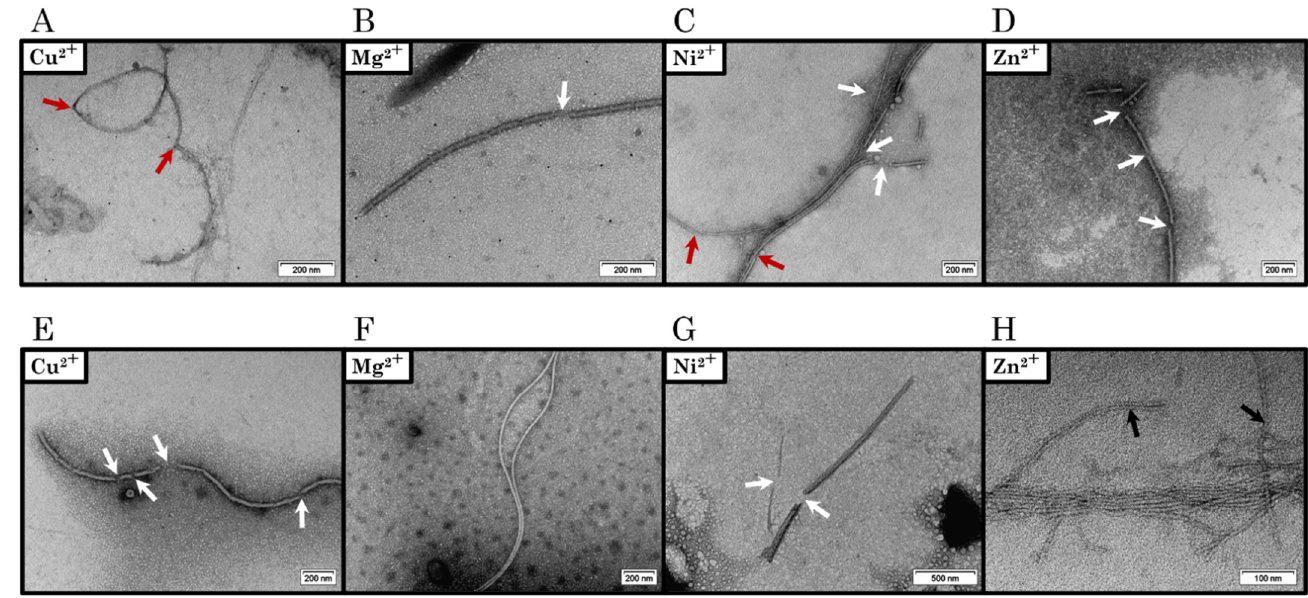
Figure 11. Negatively stained TEM micrographs of ( A – D ) C ‐ TERb and ( E – H ) C ‐ TERa (C C ‐ TER = 5 μ M) incubated for 144 h (6 days) in TBS at ~20 °C in the presence of ( A , E ) Cu 2+ , ( B , F ) Mg 2+ , ( C , G ) Ni 2+ , and ( D , H ) Zn 2+ cations (C M2+ = 100 μ M). Under certain conditions, the formed fibrils present breaking points (indicated by red arrows) and happen to be fragmented (breakages are indicated by white arrows). In Panel H, black arrows pinpoint single straight fibrils (SSFs) that cluster into multiple straight fibrils (MSFs). The scale bar is provided at the bottom right of each TEM micro ‐ graph.